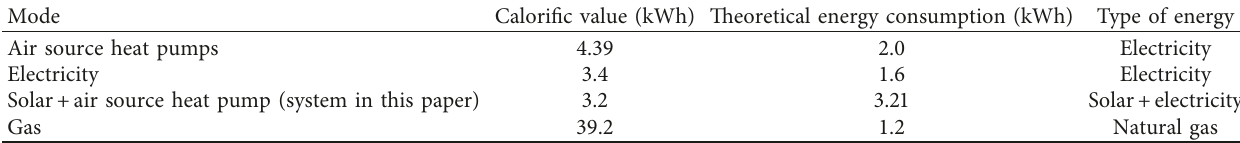
Table 1: Calorific value under different hot water preparation methods.